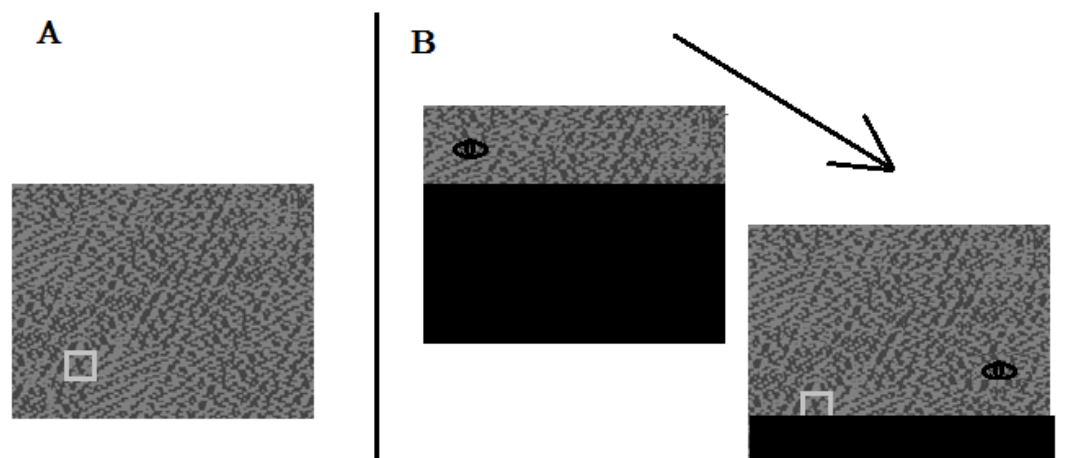
Figure 2. A. Sample stimulus display with a target square. The contrast of the target is exaggerated in the figure. B. Sample view of a participant who first looks to the upper left of the display (see the eye), and then to the lower